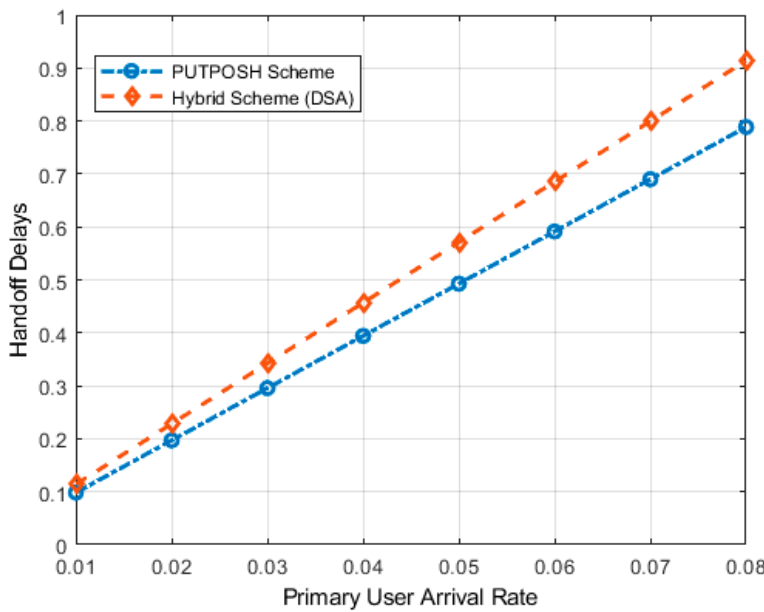
Figure 11. Comparison of proposed handoff and a hybrid approach (dynamic spectrum aggregation